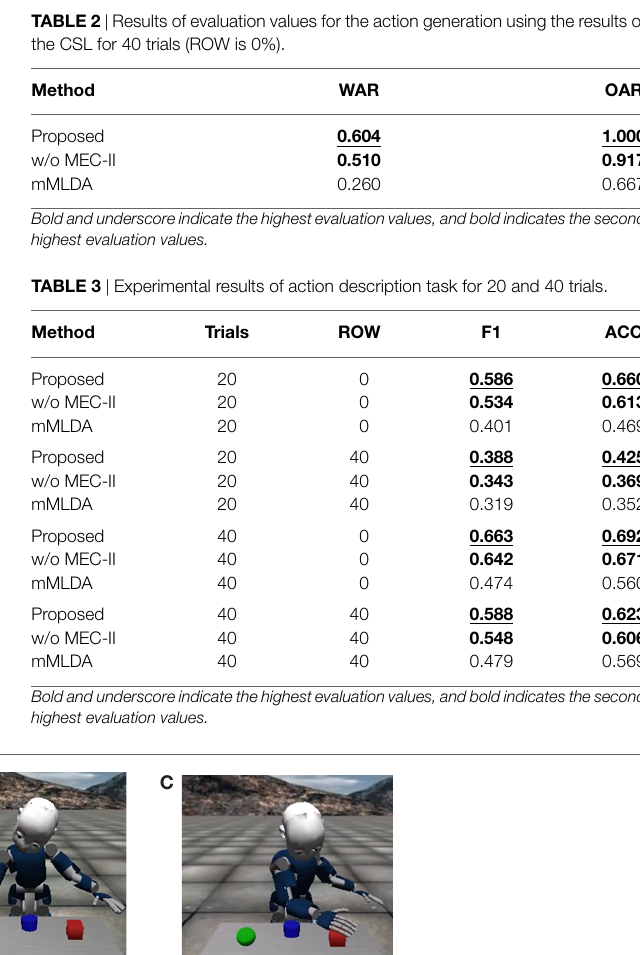
Frontiers in Neurorobotics |